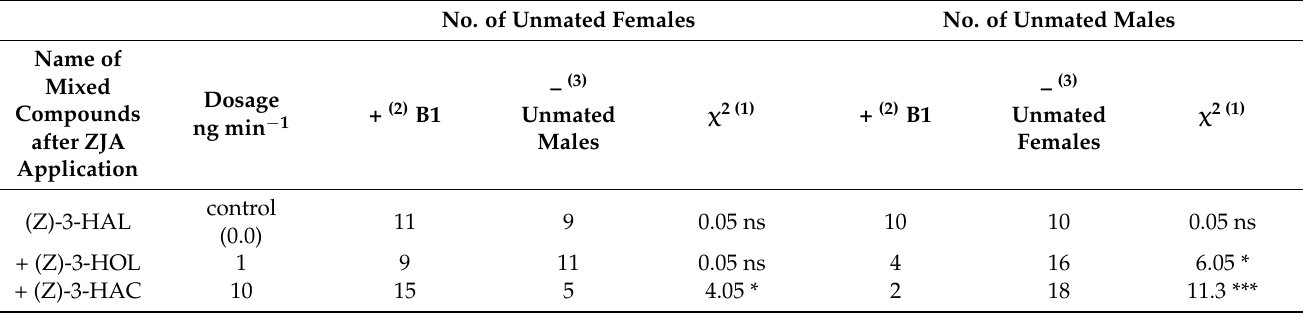
Legend for Tables 5–8: (1) level of significance (ns—not significant), (* p < 0.05), (** p < 0.01), (*** p < 0.001), (2) +